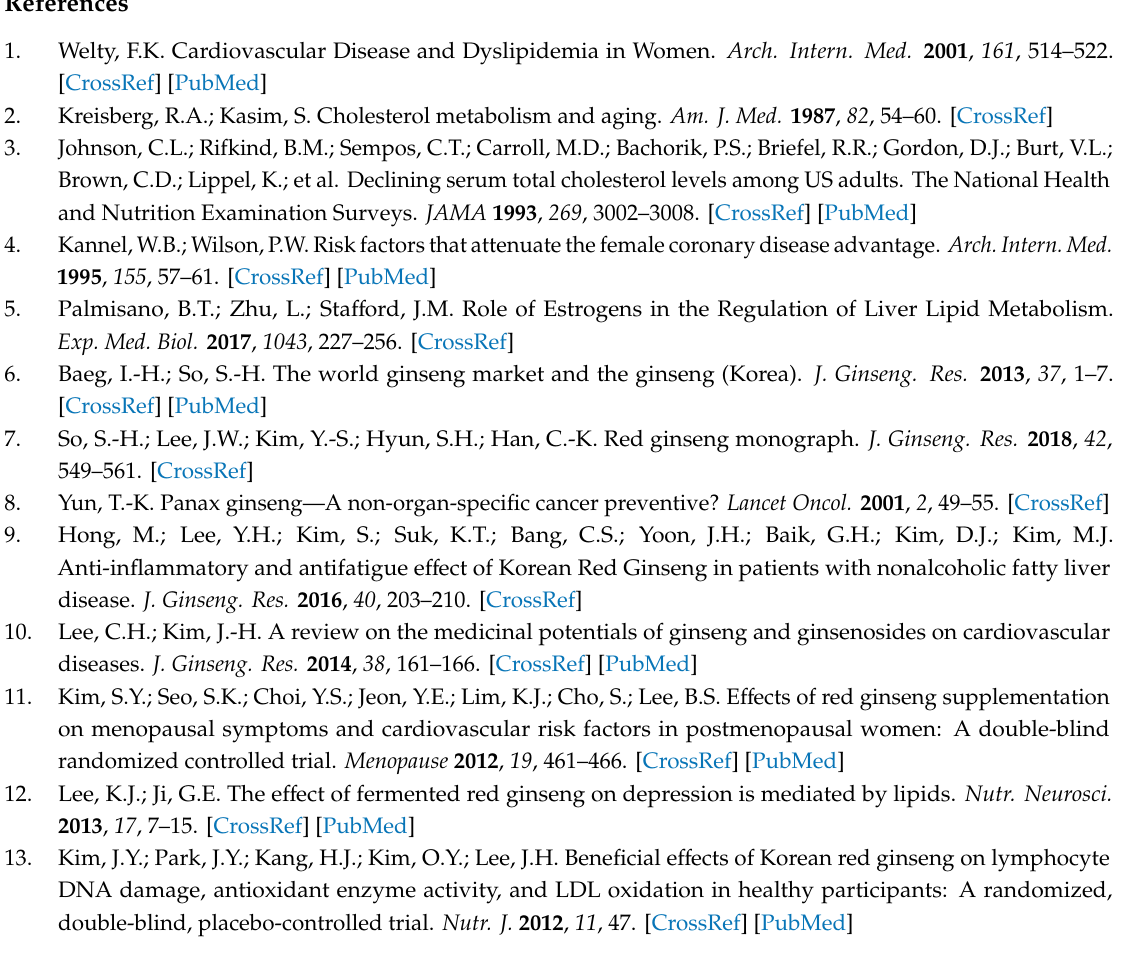
Table S1: The selective reaction monitoring transitions (Q1 and Q3 ions) and collision energies used for the sterol